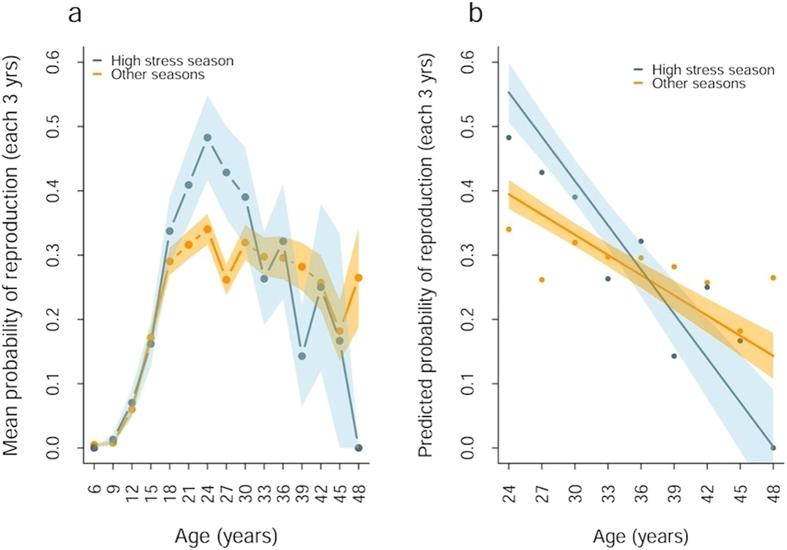
Mean three yearly reproductive rates (a) across the lifespan and (b) in the senescent phase in female Asian elephants by high stress birth season.In (a) The raw age-specific means (points) suggest an initial increase, followed by a peak at 24 and subsequent decline (also found in model1524, Table S3). The points show the mean probability of reproduction for all individuals by birth season in the raw data (6,483 records from 1,078 female elephants) and the shaded areas show the standard errors around these points. In (b) Mean three yearly probability of reproduction in female Asian elephants aged over 24 by ‘high stress’ birth season (2,059 data points from 455 females). The lines show predictions from the best fitting model (Table 1) fitted to individuals aged over 24, the shaded areas are SE values from the same model. The points show the mean probability of reproduction for each 3-year interval in the raw data by ‘high stress’ birth season.